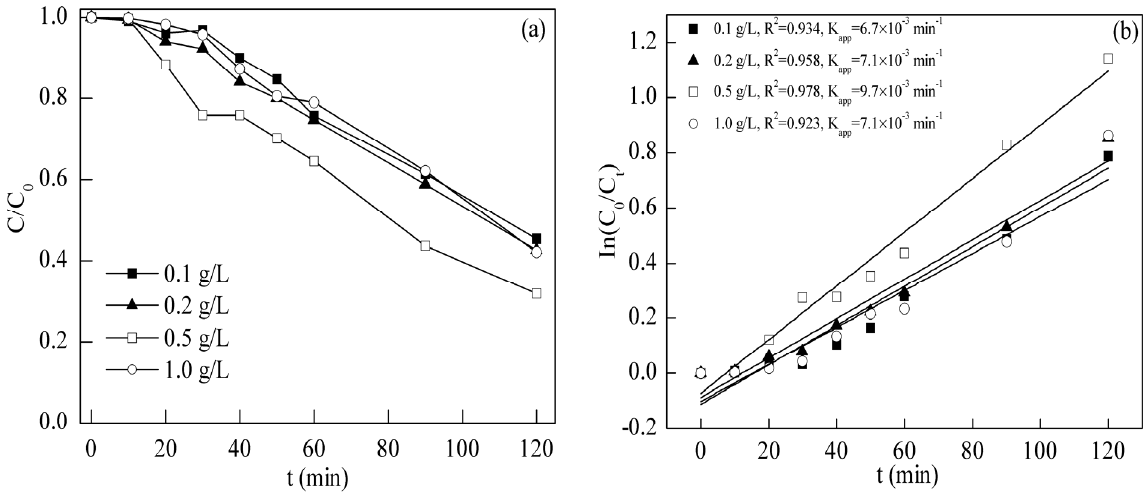
Figure 3. ( a ) Degradation and ( b ) removal kinetics of TC at different BFO dosages under visible light irradiation (initial TC concentration = 10.0 mg/L, pH = 3.0, time = 120 min).